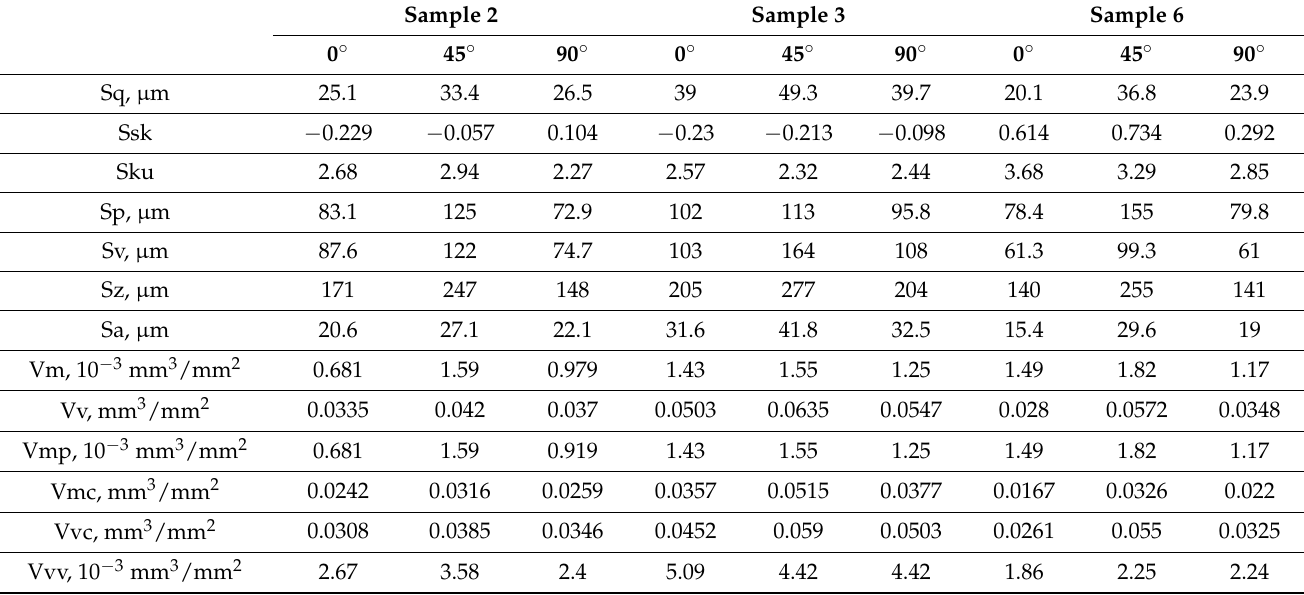
Figure 10. Process control: ( a ) standard type of basing, ( b ) improved type of basing according to the "dimple" module. Table 6. Values of selected 3D parameters for selected